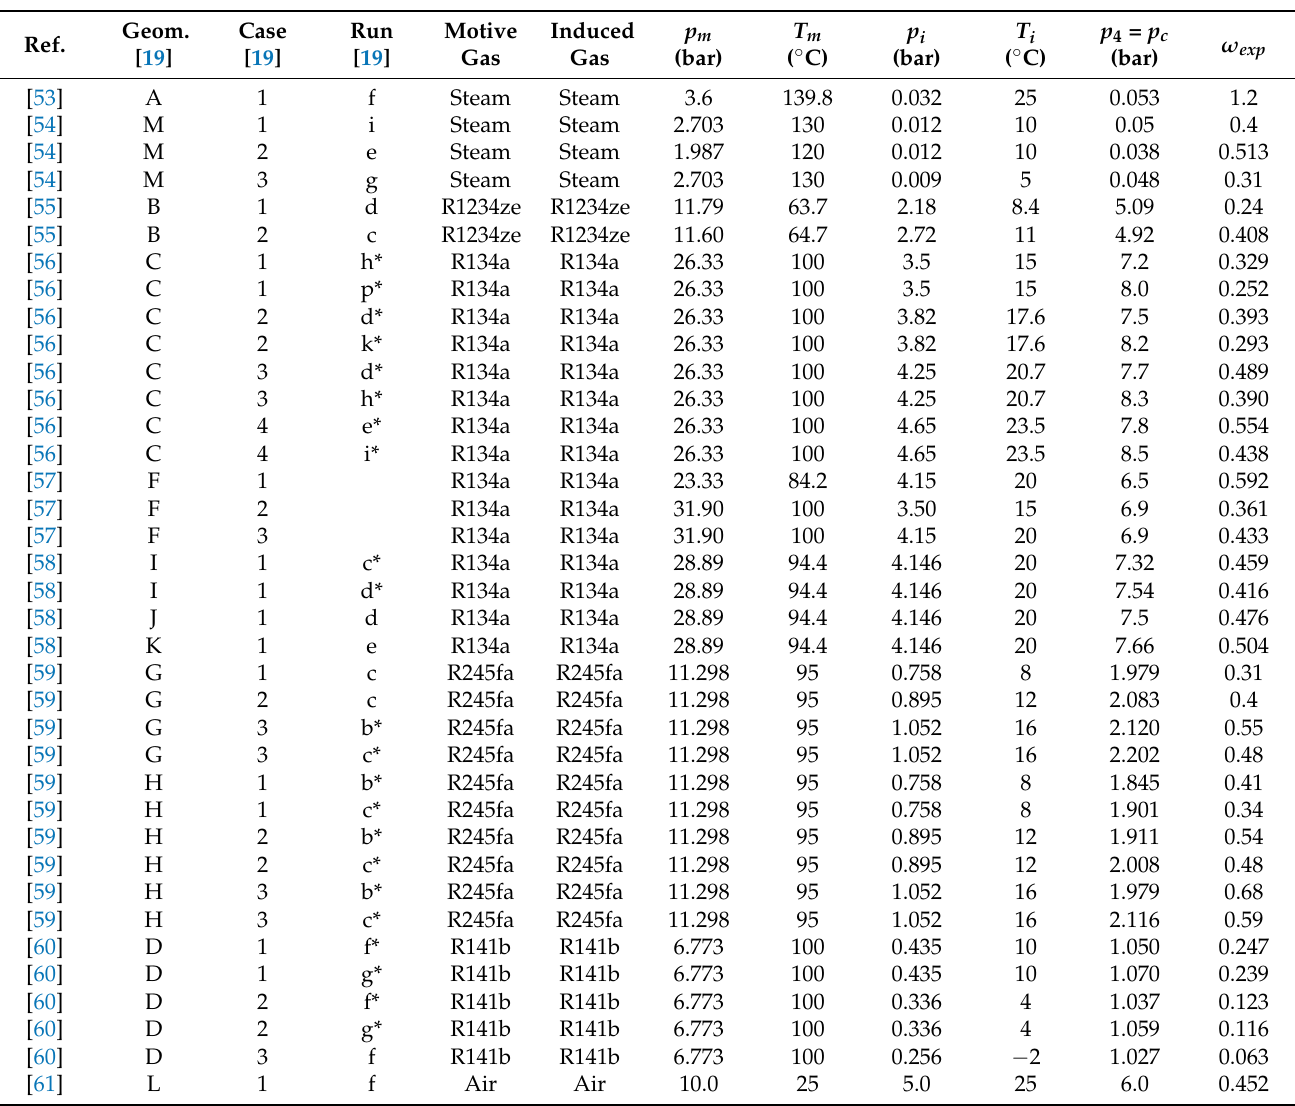
Table 2. Operating data of the first series of benchmark ejectors built and tested experimentally by the authors indicated in the first